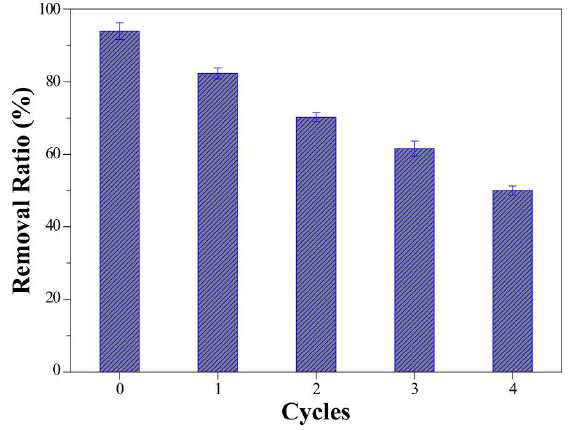
Figure 9. U(VI) removal ratio versus cycles (C 0 : 19.7 mg∙L −1 , NaF: 2 g∙L −1 , sorbent: 0.2 g, volume: 1 L, time: 144 h, and temperature: 25 °C).